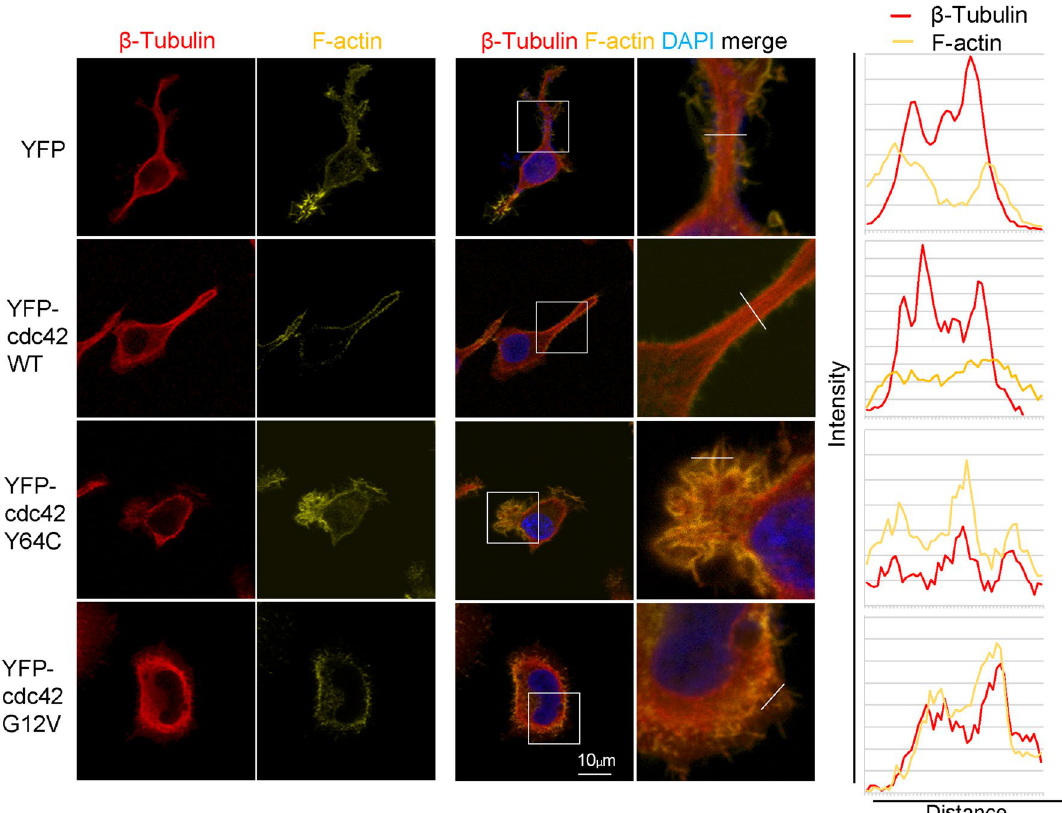
Figure 5. Abnormal colocalization of β-tubulin with F-actin in MK protrusions by Y64C expression. ( a ) Representative images of YFP-tagged cdc42- or YFP-expressing MEG-01 cells stained for F-actin (yellow), β-tubulin (red), and DAPI (blue) after 7-day culture in the presence of VPA. White squares indicate the magnified zone. ( b ) Line scans of F-actin (yellow) and β-tubulin (red) fluorescence intensity along the white line from a representative image from a. Scale bar: 10